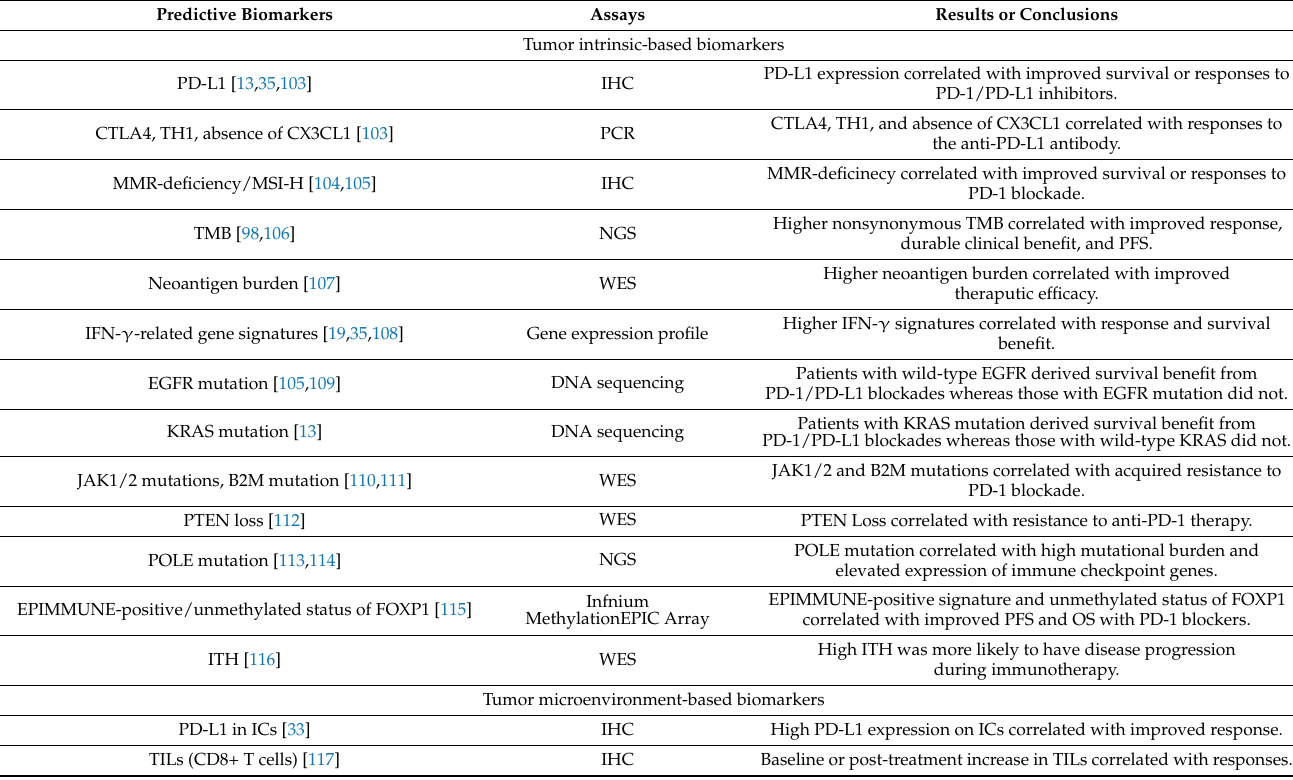
Table 2. Summary of potential predictive biomarkers in the treatment of PD-L1/PD-1